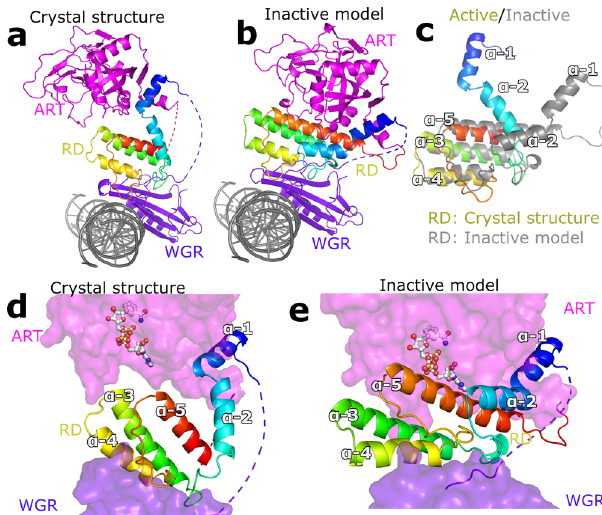
Fig. 3 Conformational changes upon PARP2 activation. a Activated PARP2 structure. b A model of PARP2 binding to DNA in an inactive conformation where the PARP2 RD-CAT crystal structure (PDB id. 4TVJ) 36 was positioned as observed on the PARP1 structure (PDB id. 4DQY) 15 . c Close up view comparing the RD domain in the active and inactive conformations. d Illustration showing how DNA activation releases autoinhibition of the catalytic domain allowing substrate binding (BAD shown in sticks, PDB id. 6BHV) 25 . e RD in an inactive state blocks the binding of the substrate NAD +